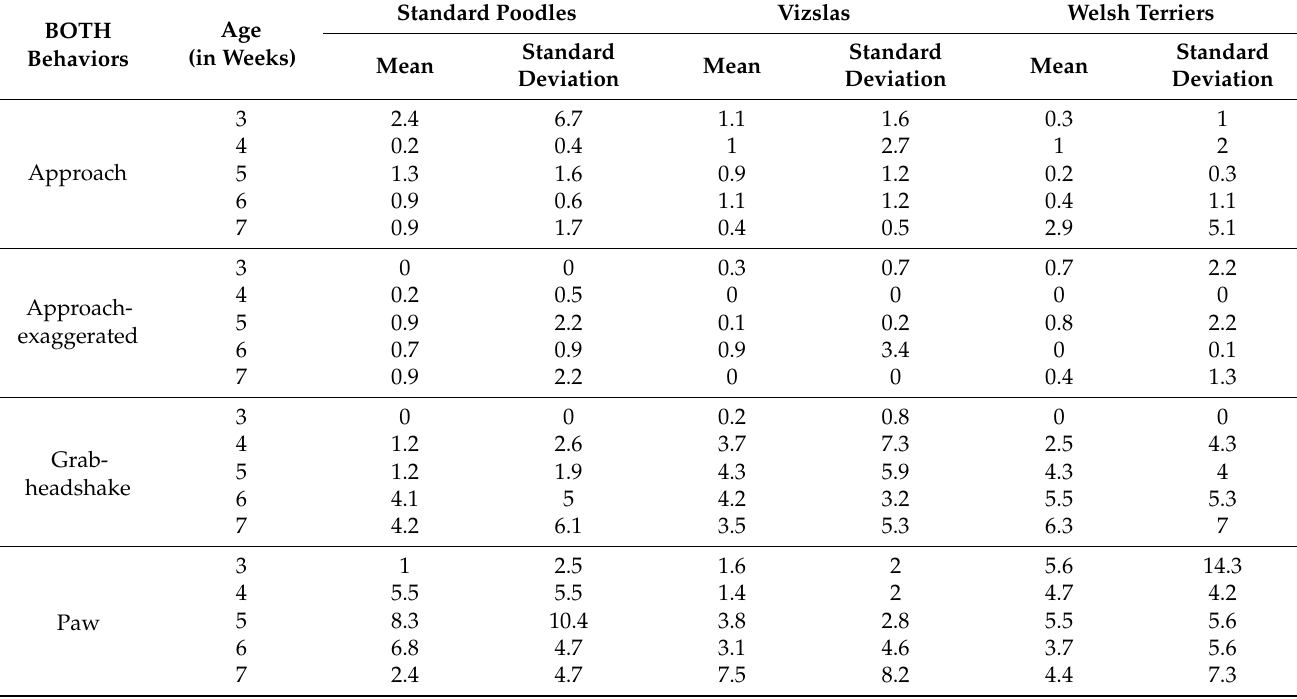
Table A4. Individual behaviors in the BOTH play context for each breed. Mean and